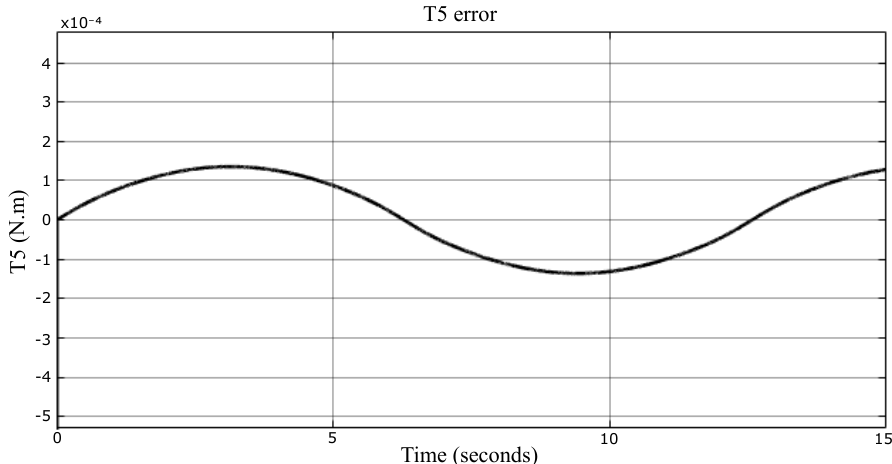
Figure 27. Torque error signal of the fourth actuator.